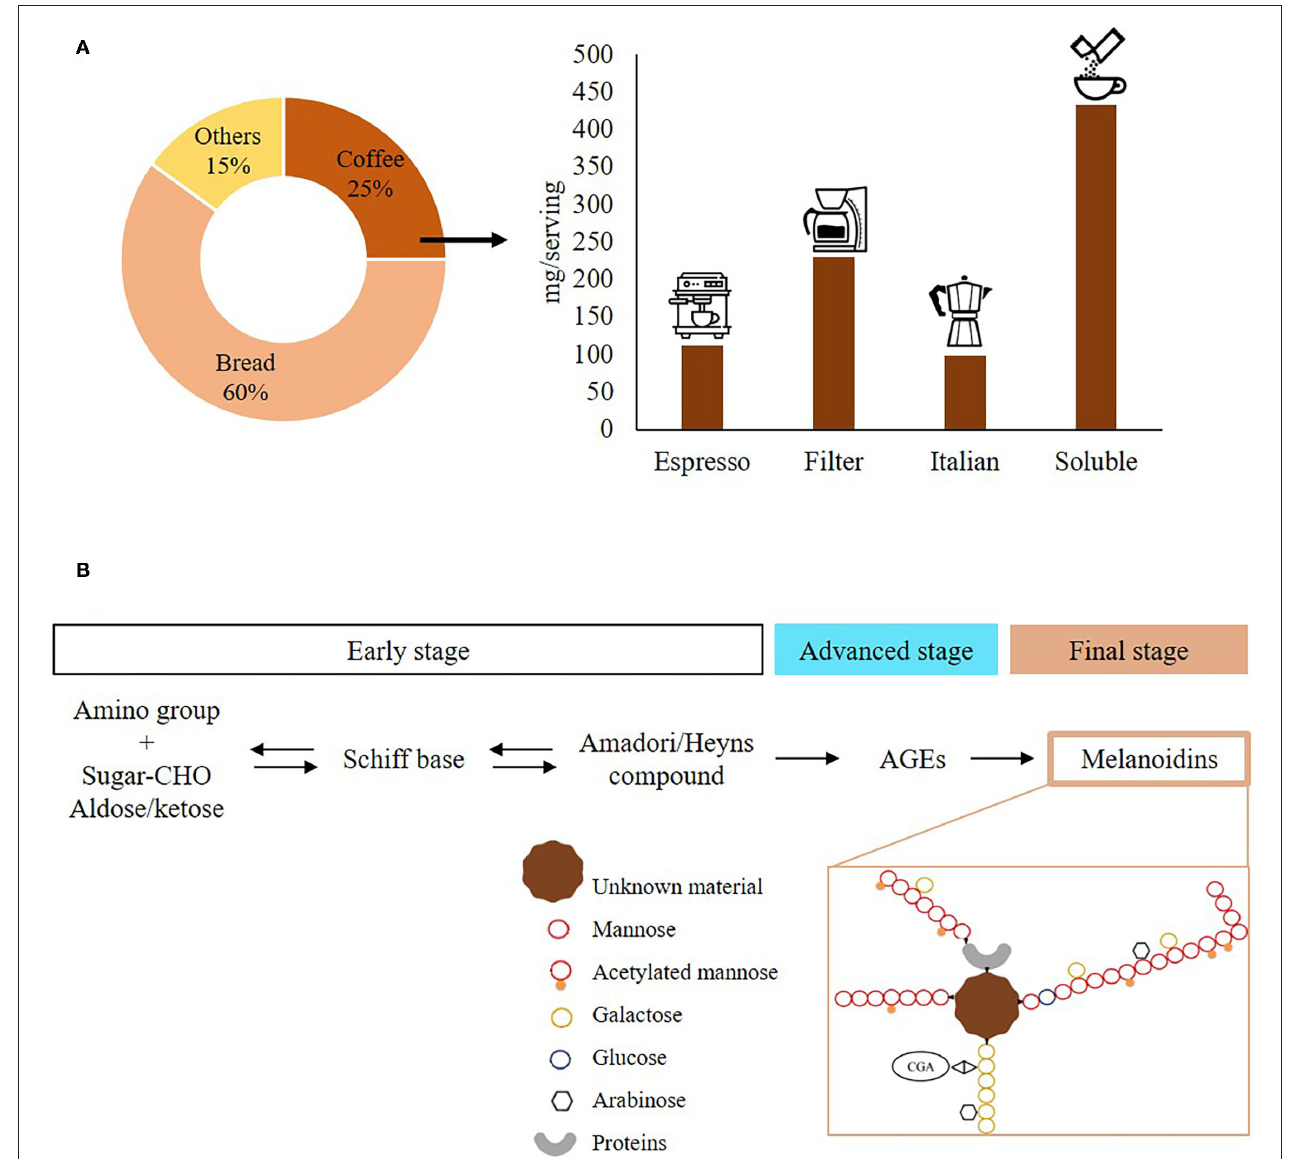
FIGURE 1 | Coffee melanoidins. (A) Dietary intake of coffee brew melanoidins. (B) Pathway of formation and structure of coffee brew melanodins. Information adapted from references (1) and (2),